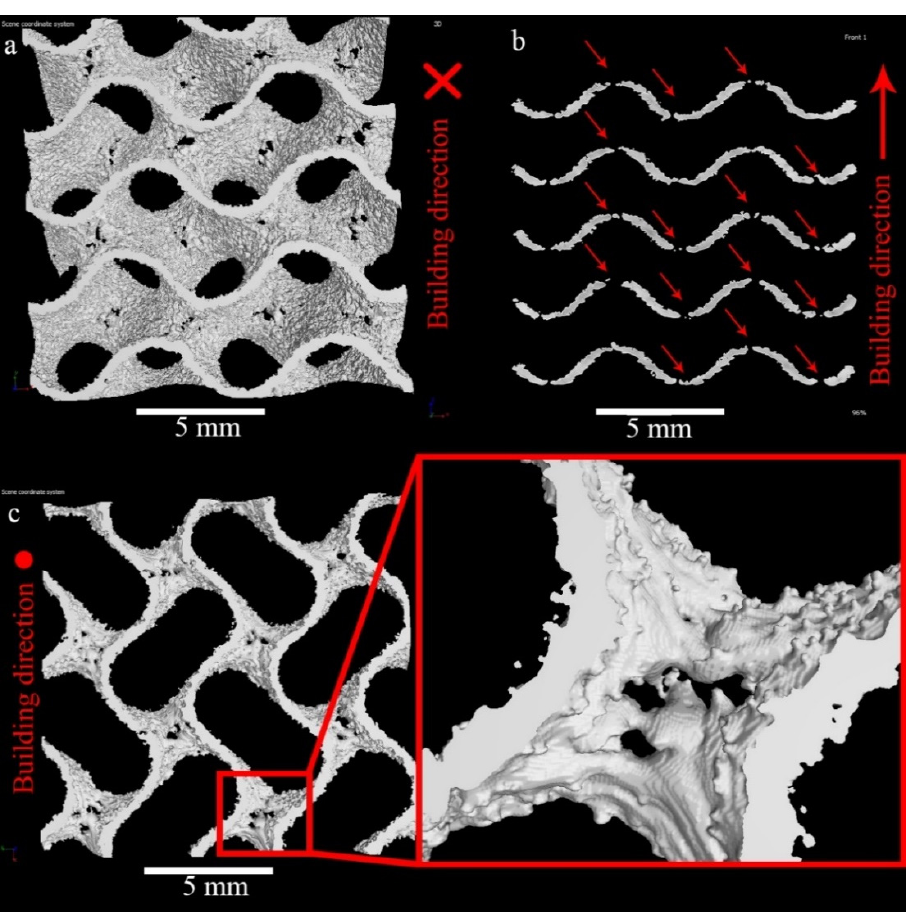
Figure 5. 3D rendering of CT-reconstruction of WT gyroid vertical ( a , c ) and horizontal ( b ) views ( a —bottom view; c —top view; b —side view).